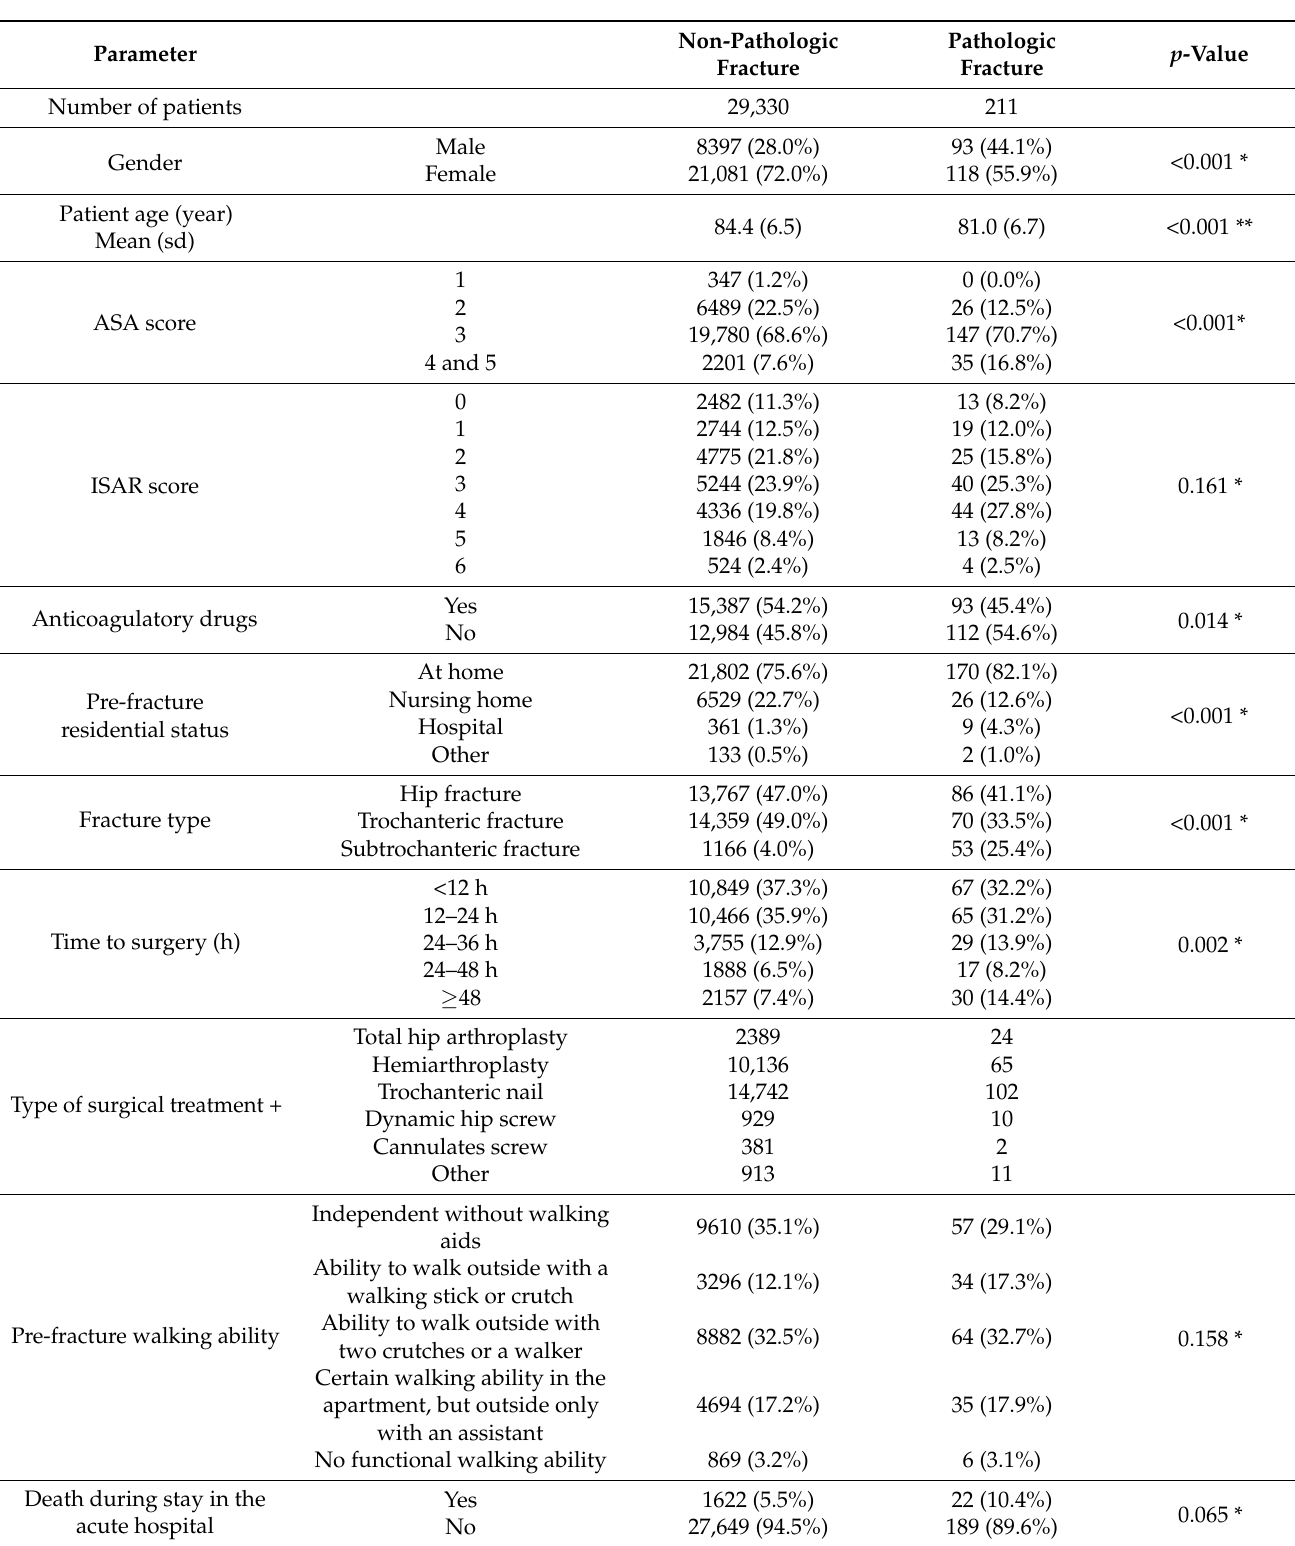
Table 1. Univariable analysis of unmatched data on geriatric trauma patients with hip fractures depending on the kind of fracture